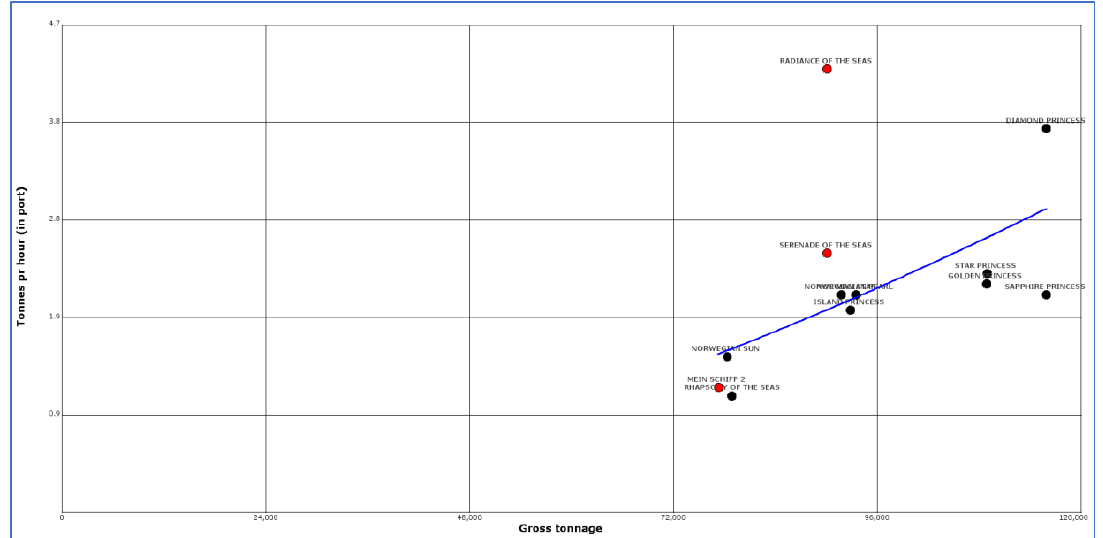
Figure 1. Fuel consumption in port for different cruise ships. The blue line is a fitted log-log trend line.